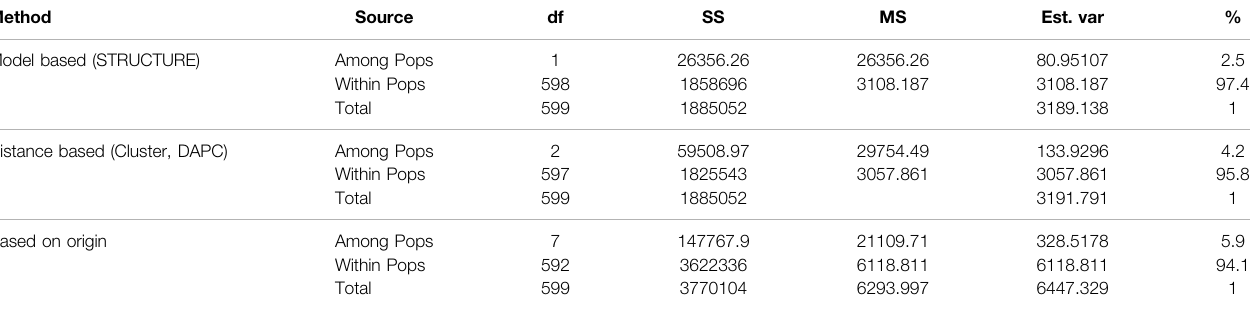
TABLE 2 | Analysis of molecular variance (AMOVA) revealing genetic diversity in bread wheat